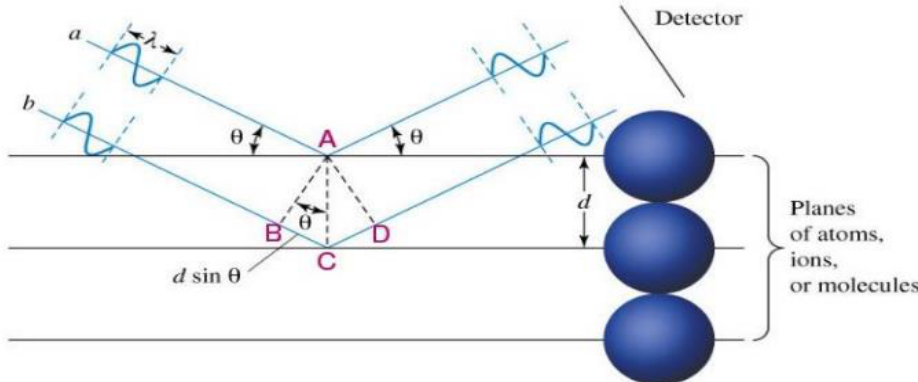
Figure 2. Bragg’s reflection from first crystal plane. Constructive interference θ i = θ r (In phase) Destructive interference θ i (cid:54) = θ r (out of phase) From the right angled triangle, BAC, the length BC is perpendicular and AC is the